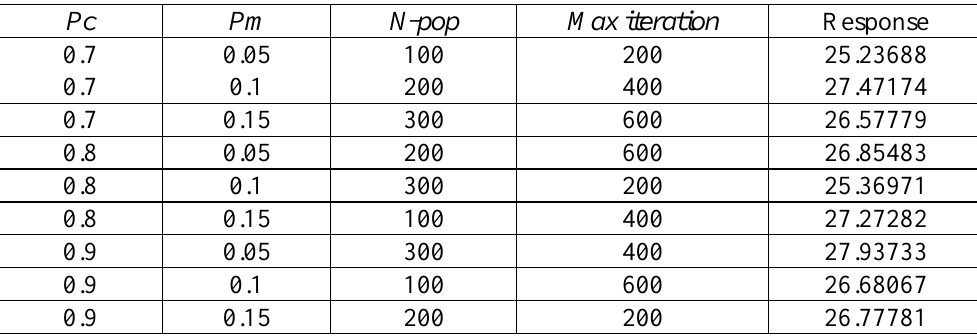
Table 2 . The orthogonal array L 9 and results for